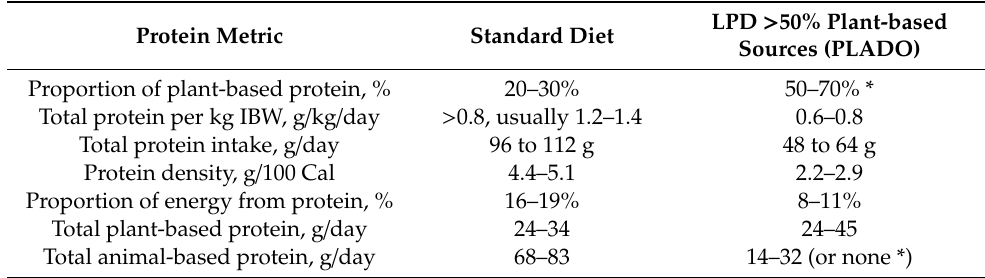
Table 4. Comparing Low Protein Diet (LPD) > 50% plant-based protein sources. Known as PLADO, versus standard diet, based on 2400 Cal / day in an 80-kg person. Protein Metric Standard Diet